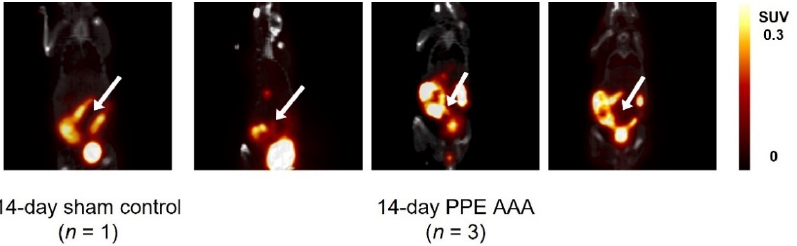
Figure 3. Coronal-view PET/CT images of static 14-day uptake of [ 18 F]FLT 80 min post-radiotracer injection in all animals. Arrows indicate the abdominal aortic region. Colour scale bars indicate SUV thresholding to aid visualisation.